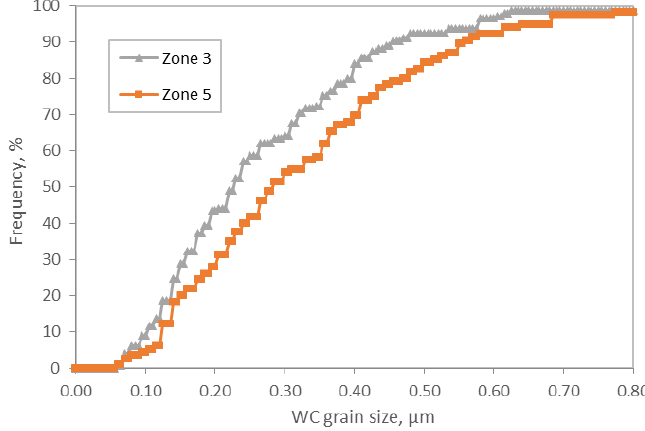
Figure 7. WC grain size distribution at zones 3 and 5 of compact sintered at 7 kA during 600 ms.